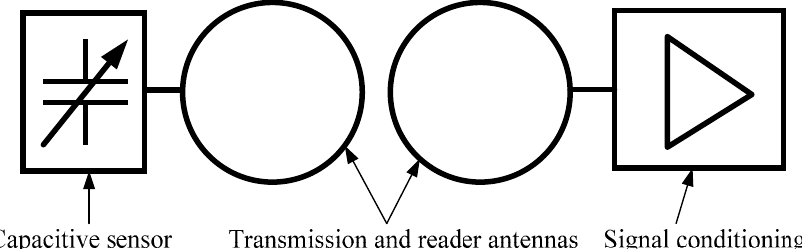
Figure 1. Diagram of the proposed wireless temperature sensor.